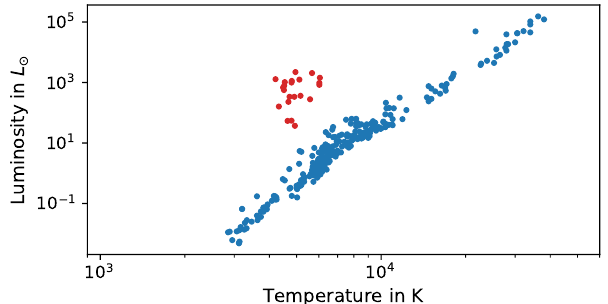
Fig. 27.— Hertzsprung-Russell diagram using physical quanti- ties (temperature and luminosity) instead of spectral classes and luminosity classes. Data from DEBCat